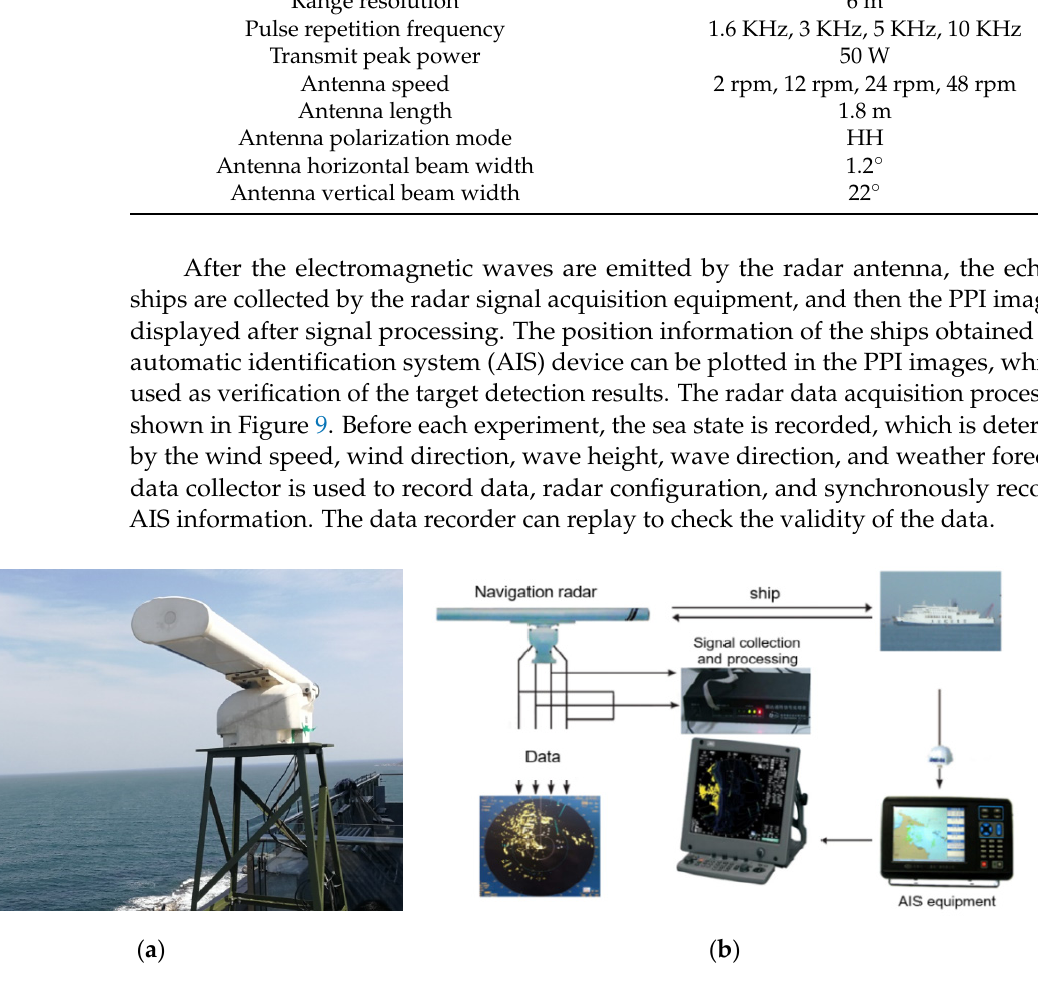
Figure 9. Navigation radar detection experiment scene and data collection process: ( a ) X-band solid-state navigation radar; ( b ) Radar data acquisition processing.